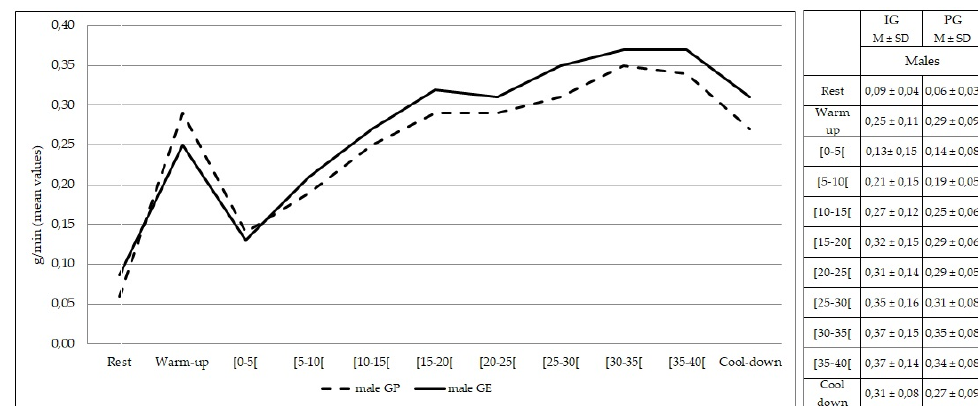
Figure 5. Lipid oxidation during rest, exercise, and cool-down in females (intervention group vs. placebo group). Data are expressed as mean ± standard deviation. IG: intervention group; PG: pla- cebo group.